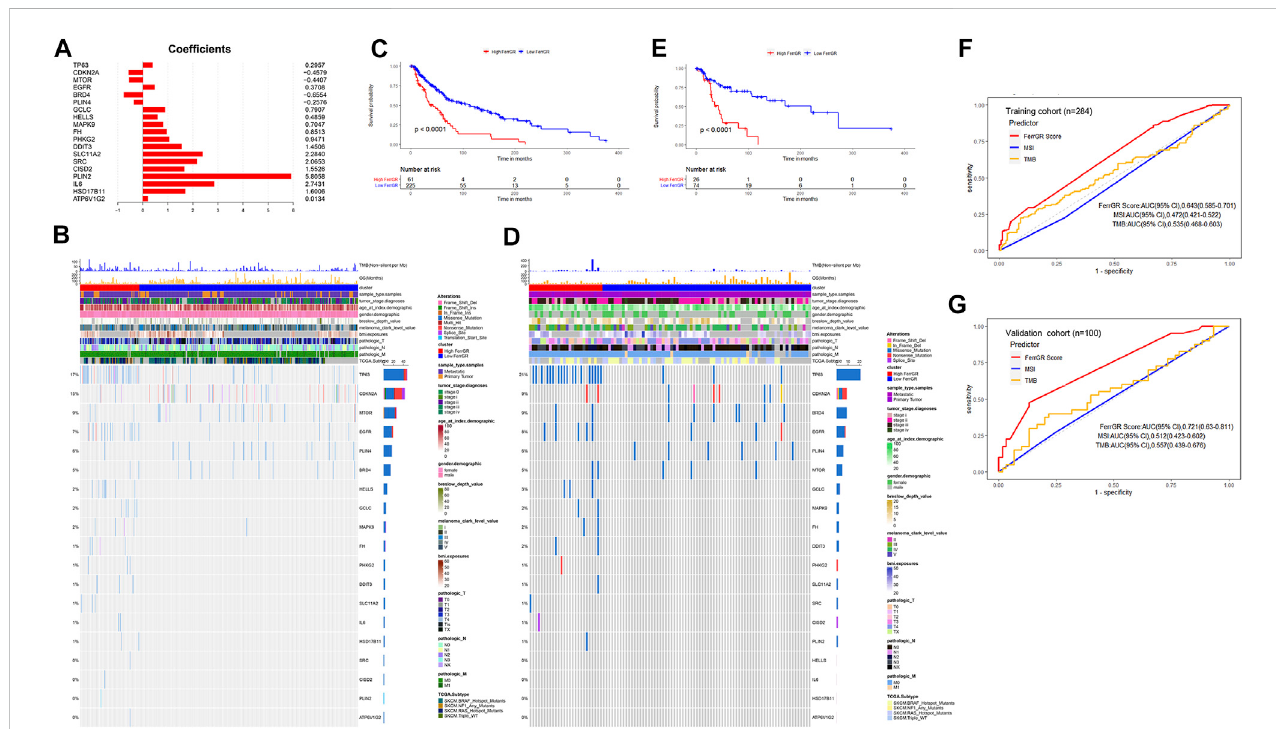
FIGURE 2 Construction and prognostic analysis of the ferroptosis-related genetic mutation risk (FerrGR)model in the training cohort and validation cohort. (A) Lassocoef fi cientspectrumof19keyFRGsintheFerrGRmodel (B,D) SNVheatmapandclinicopathologicfeaturesof19keyFRGsinthe (B) trainingcohortand (D) validation cohort. (C,E) Kaplan-Meier curves of the FerrGR model for SKCM patients with different risk groups in the (C) training cohort and (D) validation cohort. (F,G) ROC analysis of the FerrGR model compared with TMB and